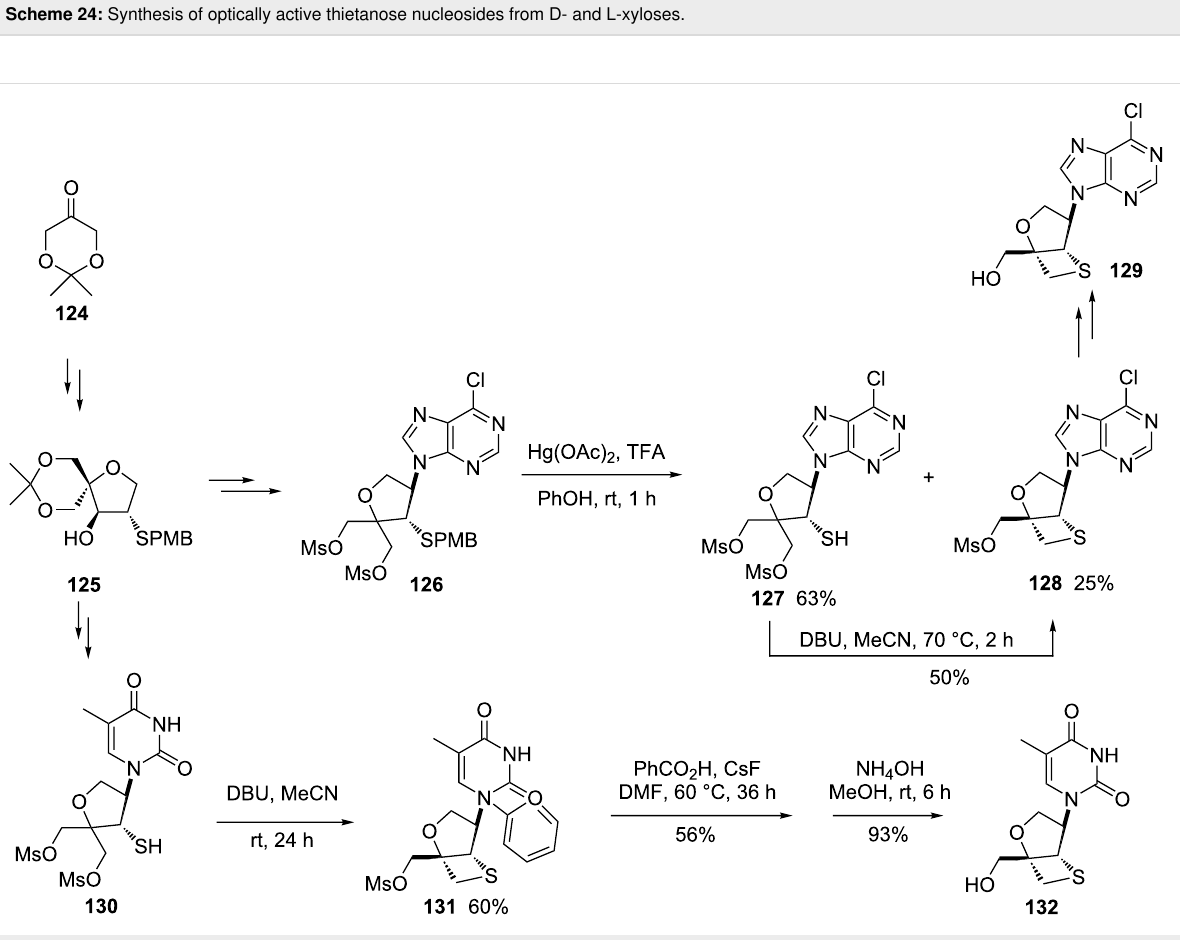
Scheme 25: Synthesis of thietane-fused